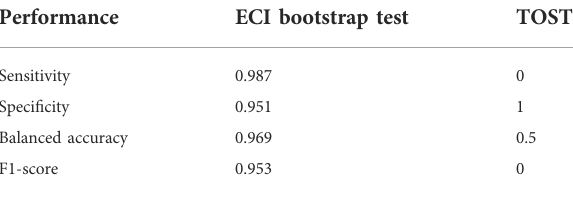
TABLE 2 Performance measurements for one single simulation with group size 20. Decisions of equivalence are made using the q-value of 0.05 for ECI bootstrap test and TOST. The TOST is too conservative to identify any equivalently changed genes, while the ECI bootstrap test shows good